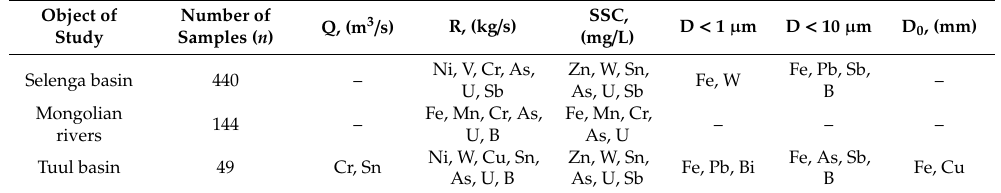
Table 2. High correlations ( r > 0.7) C susp,% revealed for certain sub-catchments of the Selenga River basin with dominant drivers of metal partitioning.